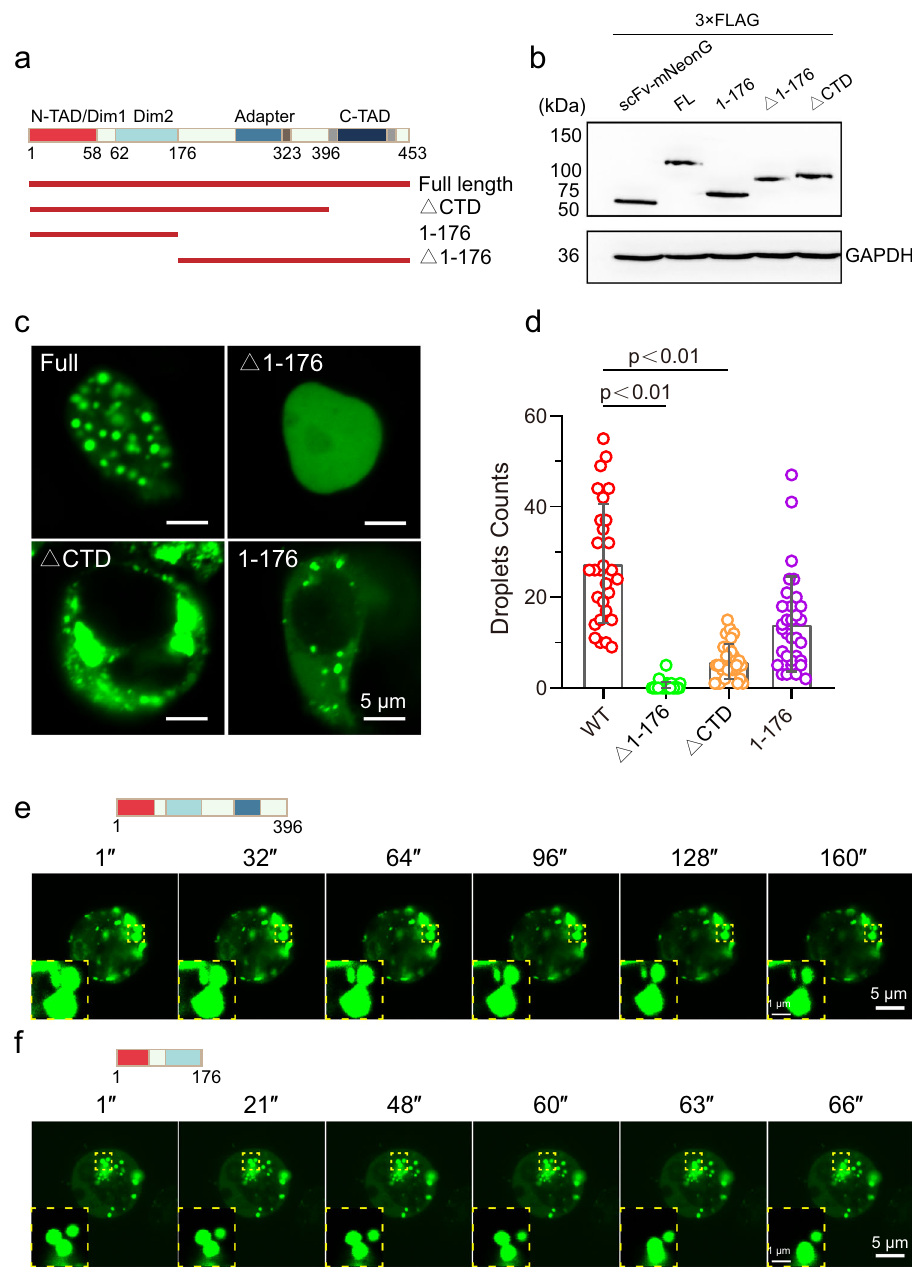
Fig. 3 The N-terminal of EBNA2 is necessary for phase separation. a Diagram of the Full length and truncated EBNA2. b Western blot of scFv- mNeonGreen protein, and full length and truncates of scFv-mNeonGreen EBNA2 protein. c Immuno fl uorescence images of the truncated EBNA2 in HEK 293 T cells (left). d The droplet counts per area of the mNeonGreen-truncated-EBNA2. Error bars represent SD. e , f Time-lapse images of both mNeonGreen-EBNA2(1-396) and mNeonGreen-EBNA2(1-176). Zoom in shows two truncated EBNA2 fusion events. Scale bars, 5 μ m, and zoom in 1 μ